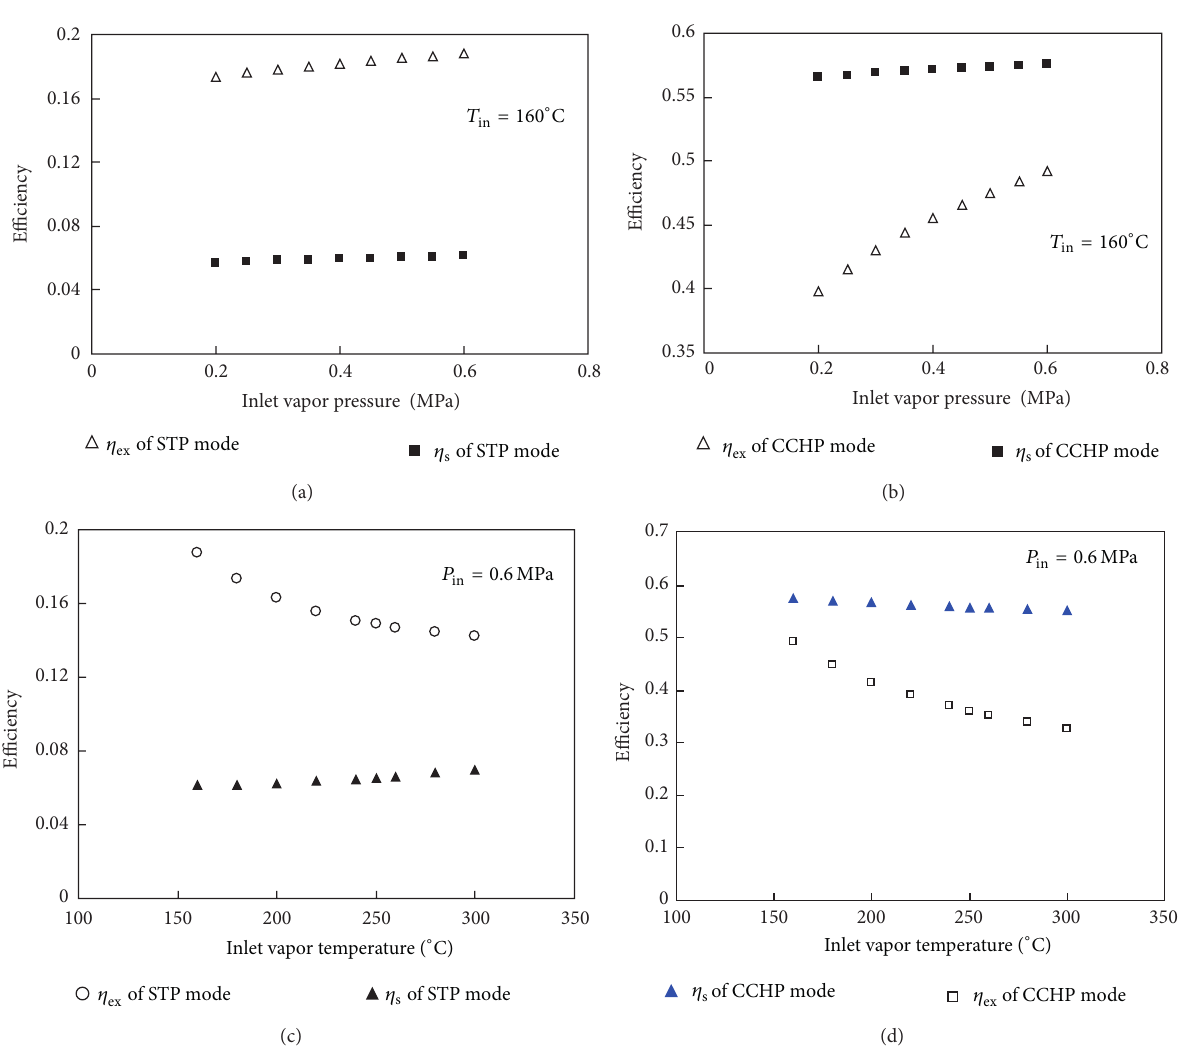
Figure 6: The effects of inlet vapor parameters on the overall efficiencies of energy and